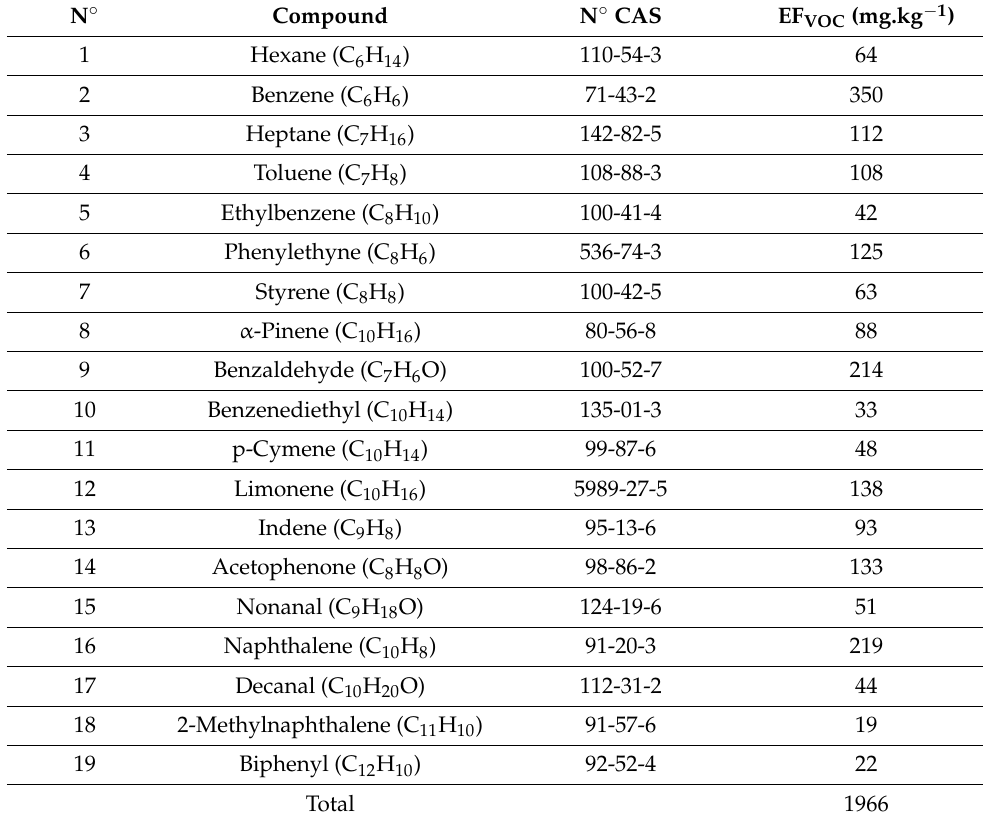
Table 4. EF for VOCs and SVOCs of wood samples.